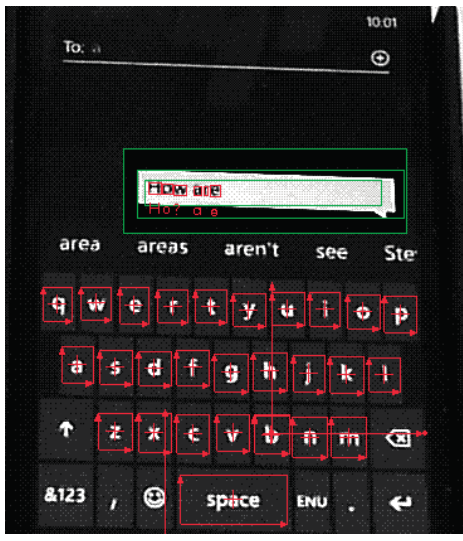
Figure 18. Check the pressed